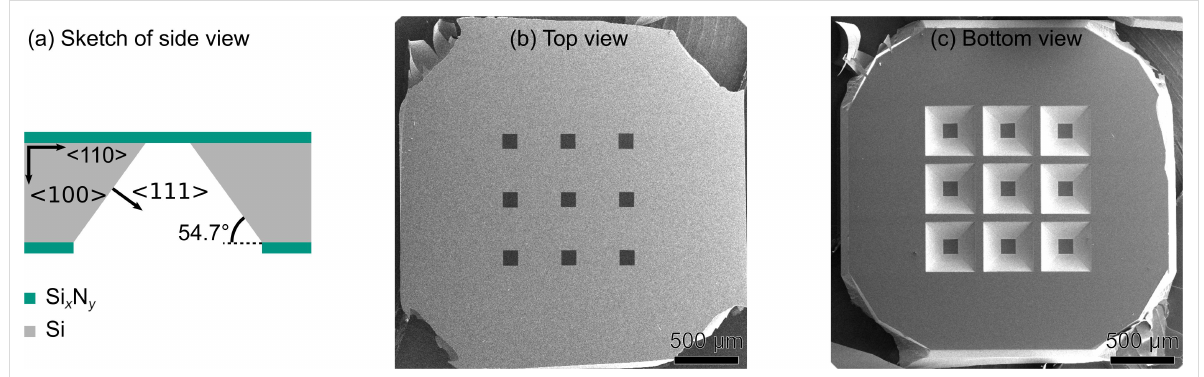
Figure 1: Samples after optical lithography and etching. (a) Scheme of side view of a single membrane. The sketch is not to scale as the Si x N y windows and the Si wafer have a thickness of 120 nm and 200 µm, respectively. SEM images of the (b) top and (c) bottom surface reveal the 3 × 3 array of Si x N y membranes and the pyramid-shaped trenches caused by anisotropic wet-etching of Si.